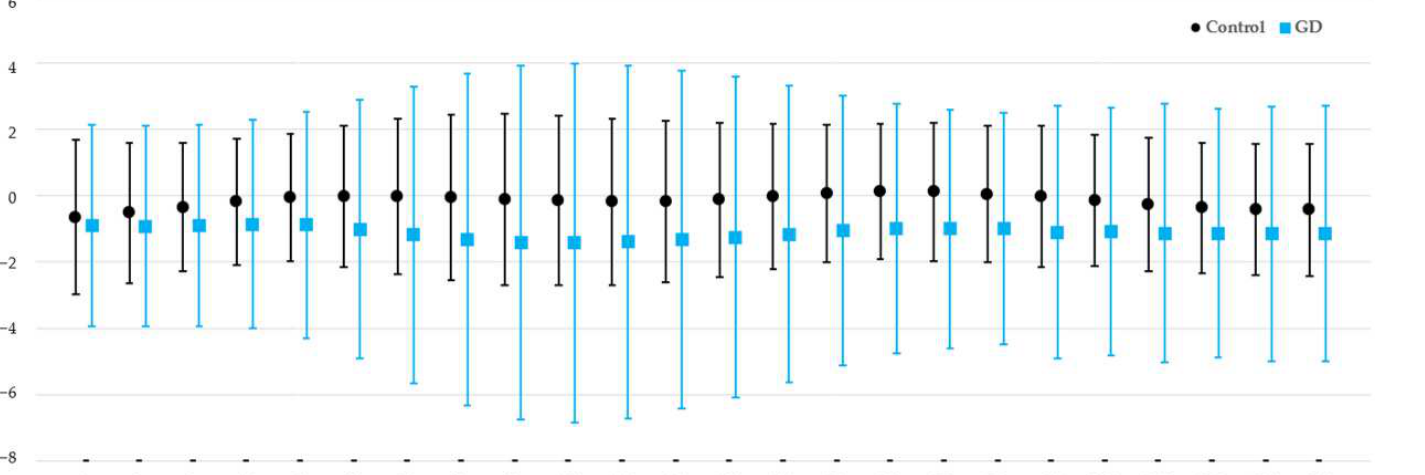
Table 2. Comparison of the right ventricular 24-segment fractional shortening between the Control group and the GD group.